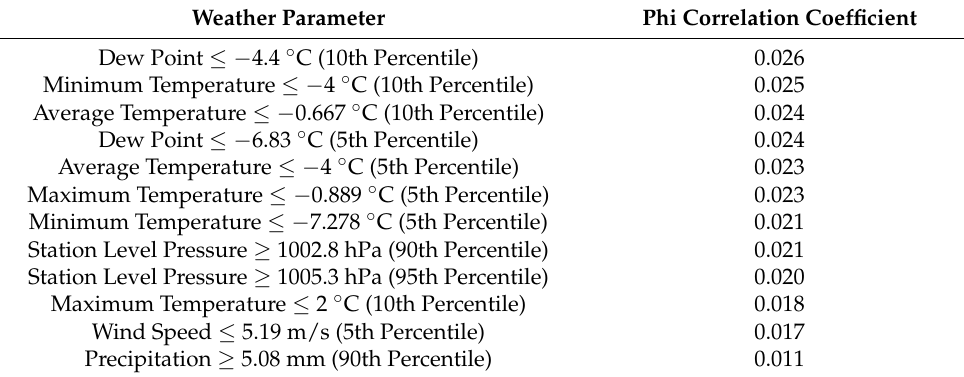
Figure 1. Risk estimation of the effect of extreme meteorological parameters on the number of COPD-related emergency visits per day, p < 0.05. Table 4. Relationship between the extreme meteorological parameters and the number of COPD- related emergency visits per day, p < 0.05. (Abbreviation: temperature and dew point values in degrees Celsius ( ◦ C); the precipitation in millimeters (mm); dew point in degrees Celsius ( ◦ C); atmospheric pressure data at the station level in hectopascals (hPa); and the wind speeds in meters per second (m/s).